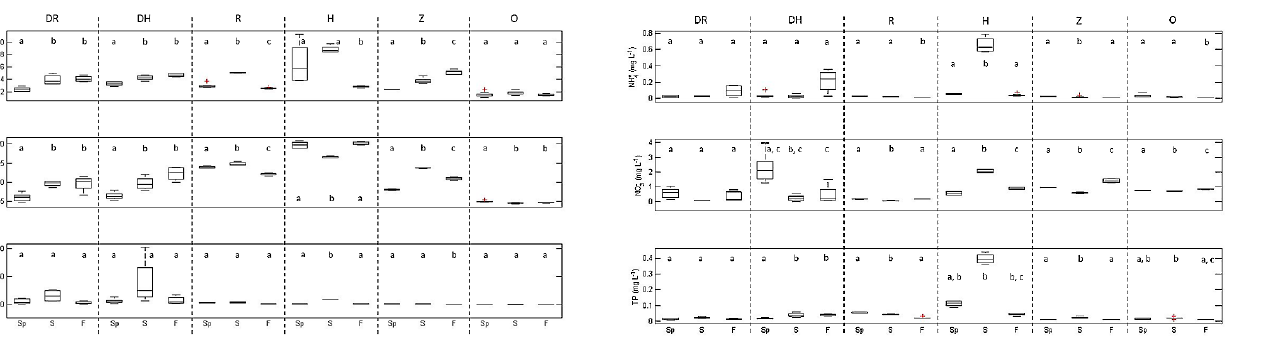
Fig. 7. Seasonal concentrations of NH + , NO − and TP in the 4 3 streams Rappbode (R), Hassel (H), Zillierbach (Z) and Ochsenbach (O) and the pre-dams Rappbode (DH) and Hassel (DH). Seasons are abbreviated as follows: Sp indicates spring, S indicates summer, and F indicates fall. The following numbers of samples were pooled in the box plots: in spring n = 6 for DR and DH, n = 7 for R, n = 8 for H and O and n = 4 for Z; in summer n = 4 for DR, DH, R and H, and n = 8 for Z and O; in fall n = 4 for DR and DH, n = 8 for R, H, Z and O. Significant differences between groups are indicated by letters a, b and